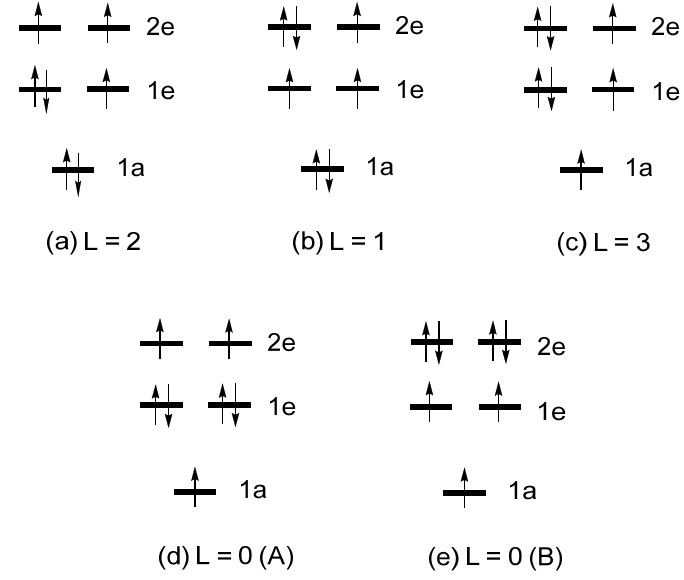
Figure 9. Five electron configurations of (Fe L 2 ) − and Co L 2 based on the d-state split pattern of 1a < 1e < 2e: ( a ) L = 2, ( b ) L = 1, ( c ) L = 3, ( d ) L = 0 (A), and ( e ) L = 0 (B) configurations.